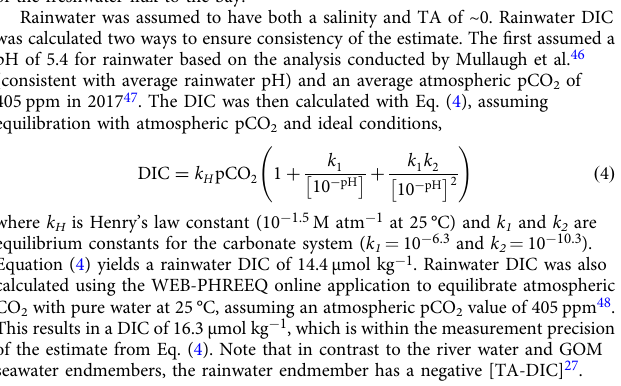
Supplementary Data 1 for comparison. The endmember values used in the calculations are summarized in Supplementary Table S3. To determine the average salinity of seawater entering Galveston Bay, salinity data were downloaded at half-hourly intervals from the Texas Automated Buoy System (TABS) Buoy B (28.98°N, 94.90°W; http://pong.tamu.edu/tabswebsite/; Fig. 1b) for September 1, 2011 to September 23, 2018. We applied quality assurance for real-time oceanography data (QARTOD) standards to the raw data to exclude outliers and extreme values. The Gulf of Mexico endmember TA S and DIC S were calculated for the median salinity (S = 31.7) and the upper and lower quartiles (S = 33.5 and 29.3, respectively) of the Buoy B data from the linear regression